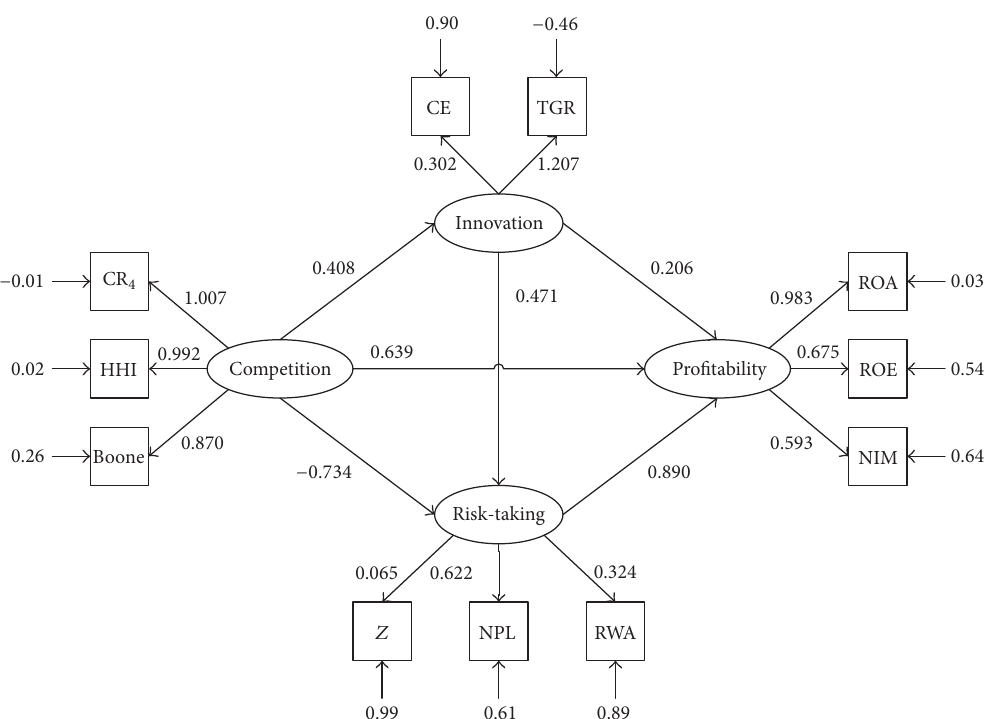
Figure 4: The path coefficients of variables. The exogenous latent variable, competition, is measured by the observed variables (CR 4 , HHI, and Boone index). The endogenous latent variables are innovation (measured by CE and TGR), risk-taking (measured by 𝑍 - score, NPL, and RWA) and profitability (measured by ROA, ROE, and